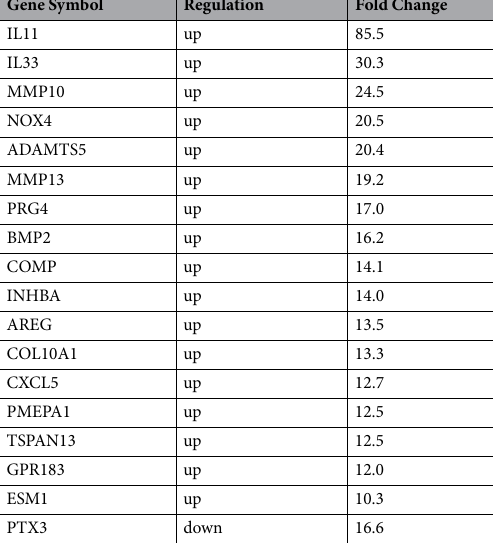
Table 2. Genes with at least 10x changes in oral fibroblasts exposed to